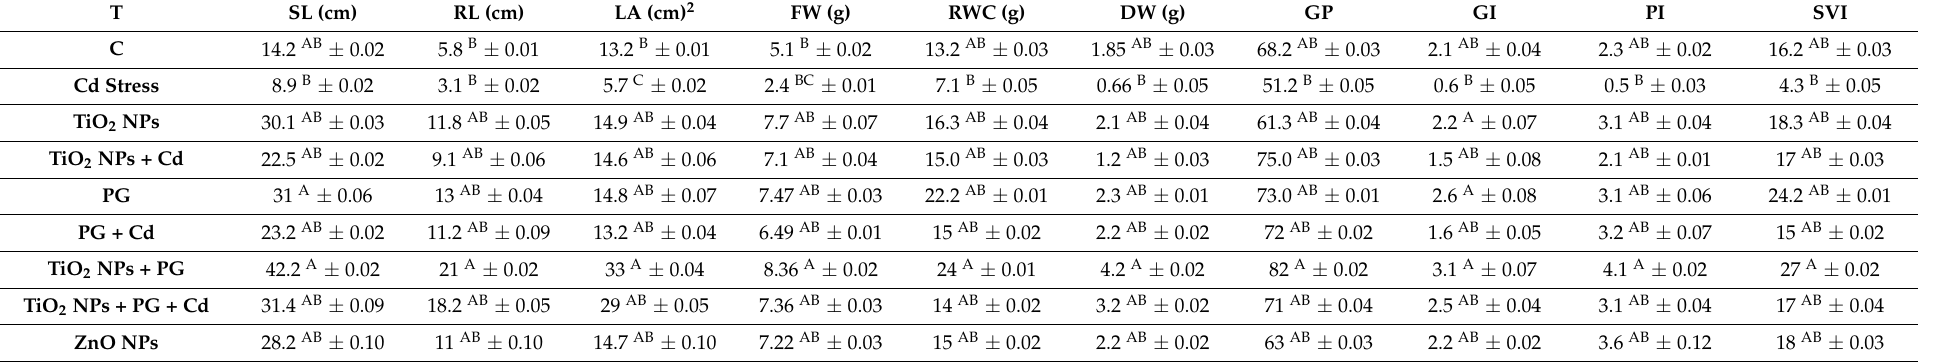
Table 4. Biomass estimations of Zea Mays L. plants treated with PGPR and TiO 2 and ZnO NPs under Cd stress (120